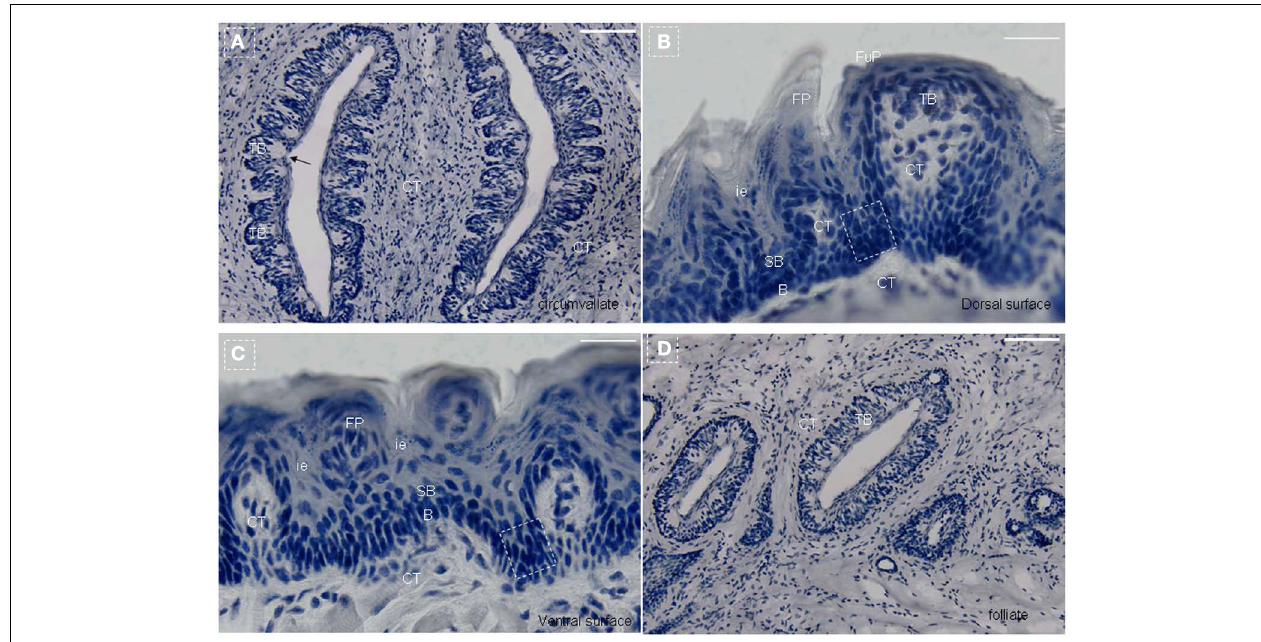
the tip of the tongue. (D) Frontal section of ventral surface in the tip of the tongue. Arrow, taste pore. Dotted frame indicates area between the arms of the U-shaped connective tissue core. B, basal cell layer; SB, suprabasal cell layer; CT, connective tissue; CV, circumvallate papillae; FP, filiform papillae; FuP, fungiform papillae; ie, interpapillary epithelia;TB, taste bud. Scale bar: 12 µ